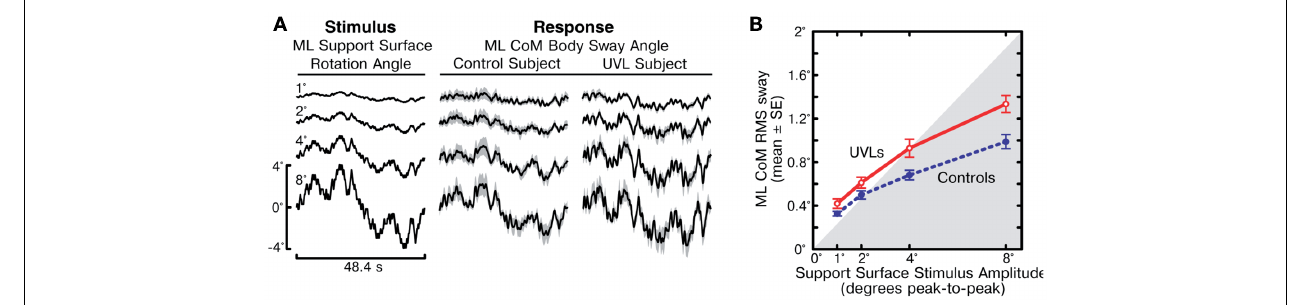
means with 95% confidence intervals (shaded gray) are shown. (B) Root mean square (RMS) values of ML body-sway are plotted as a function of peak-to-peak amplitude of the pseudorandom surface-tilt stimulus.The gray shaded region indicates the range where stimulus RMS values are less than the ML sway RMS values.